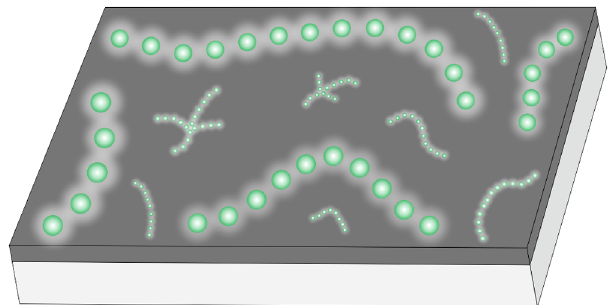
Fig. 8 Schematic reconstruction of Horodyskia moniliformis (larger beads) and Horodyskia minor (smaller beads). Reconstructions are based on specimens from the Tonian Shiwangzhuang and Jiuliqiao formations in North China. The co-occurrence of H . moniliformis and H . minor on the same bedding plane is based on specimens illustrated in Fig. 2a, f from the Shiwangzhuang